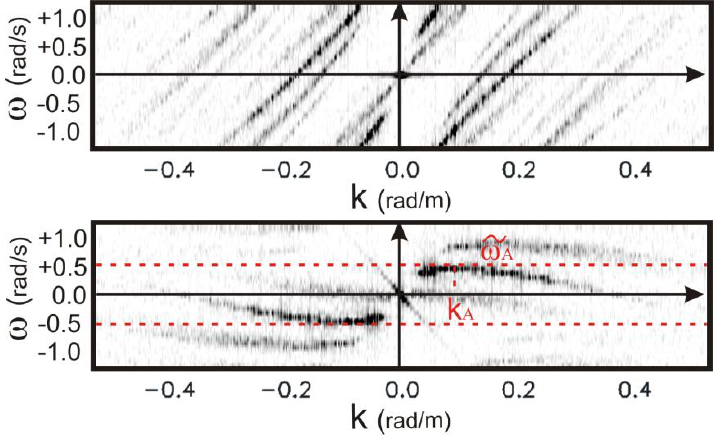
Figure 11. Upper panel: folded image spectrum   kkF ),(  . Lower panel: not folded ),(~ spectrum   kkF  after the variable change of Equation (14).